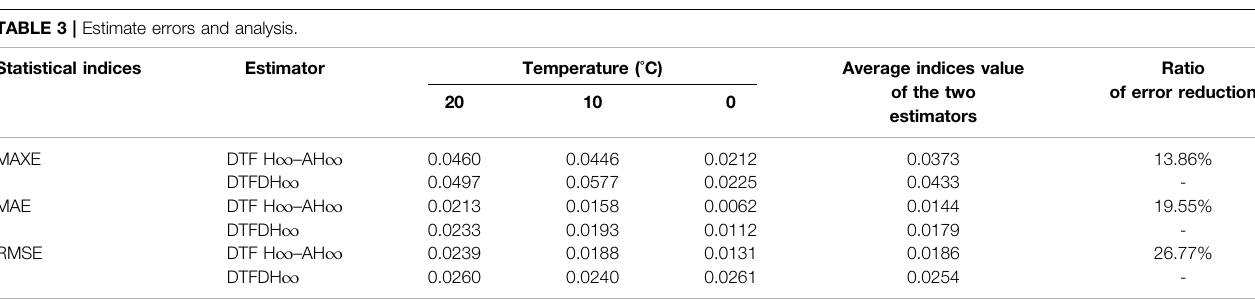
TABLE 3 | Estimate errors and